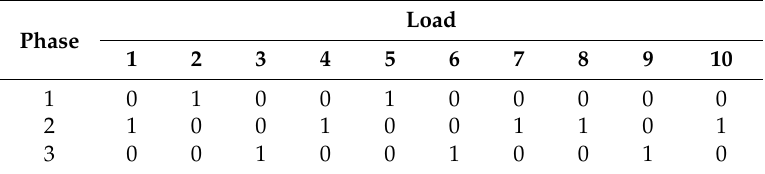
Table 1. Connection matrix for the three-phase distribution system with 10 single-phase loads [19].